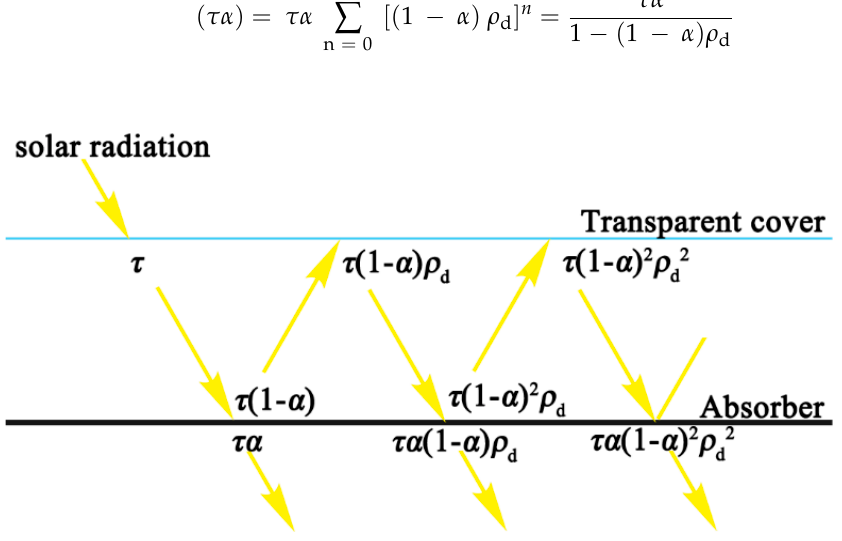
Figure 5. The processes of radiation transmission, absorption, and reflection in the transparent cover ‐ absorber system. Table 1. The values of α i .